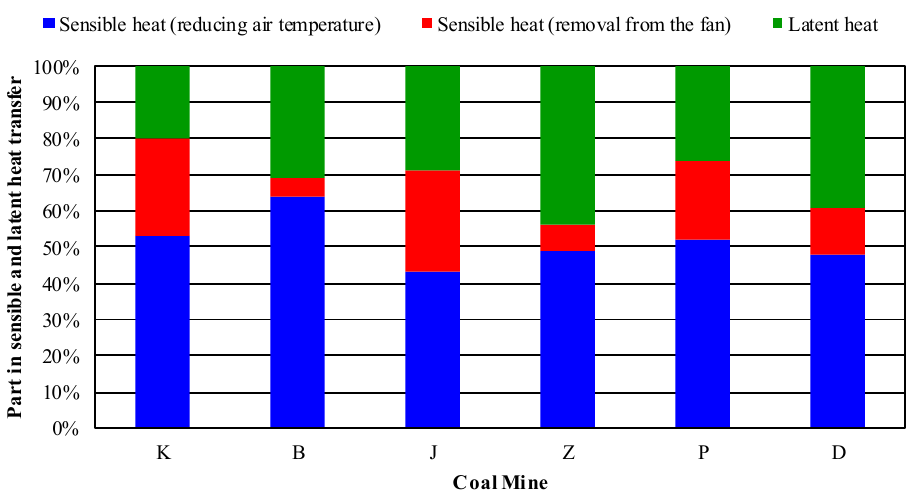
Figure 13. The contribution of cooling power to heat exchange in the spot air-coolers in particular mines.